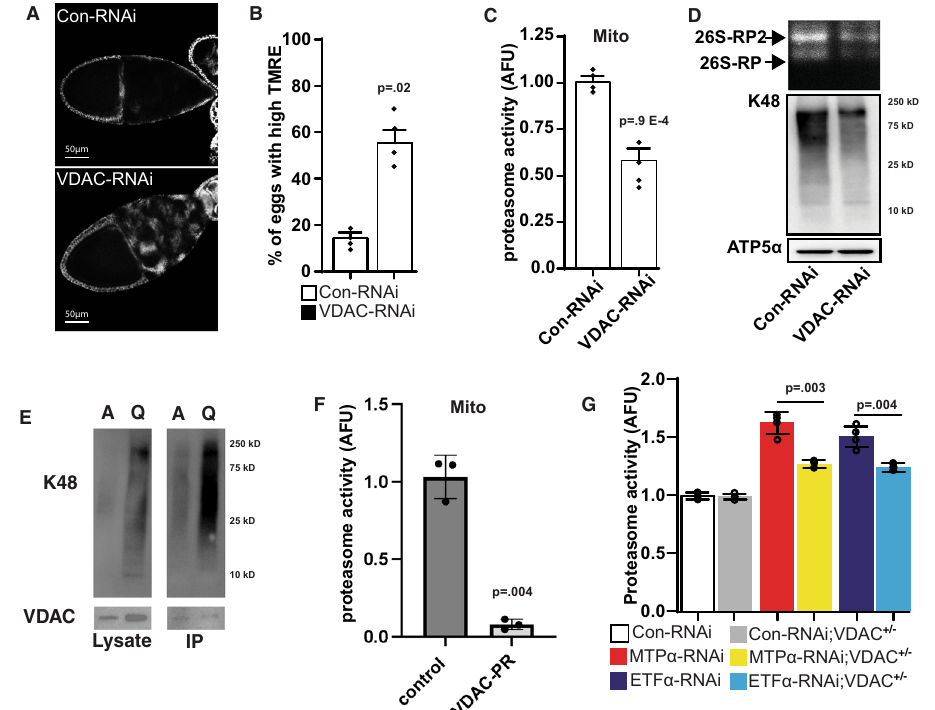
E K48 ubiquitination assay for VDAC in active and quiescent oocytes ( n =3 inde- pendent experiments). F Mitochondrial associated proteasome activity from con- trol oocytes and oocytes that overexpress a Phospho-resistant form of VDAC (VDAC-PR)( n =3independentexperiments). G EpistasisanalysisofVDAC1andFAO pathway in regulating mitochondria-associated proteasome activity ( n =5 biologi- cal replicates). P values were calculated by one-way analysis of variance (ANOVA). Error bars represent one standard deviation. ** p <0.001, * p <0.05. Error bars represent 1 X standard